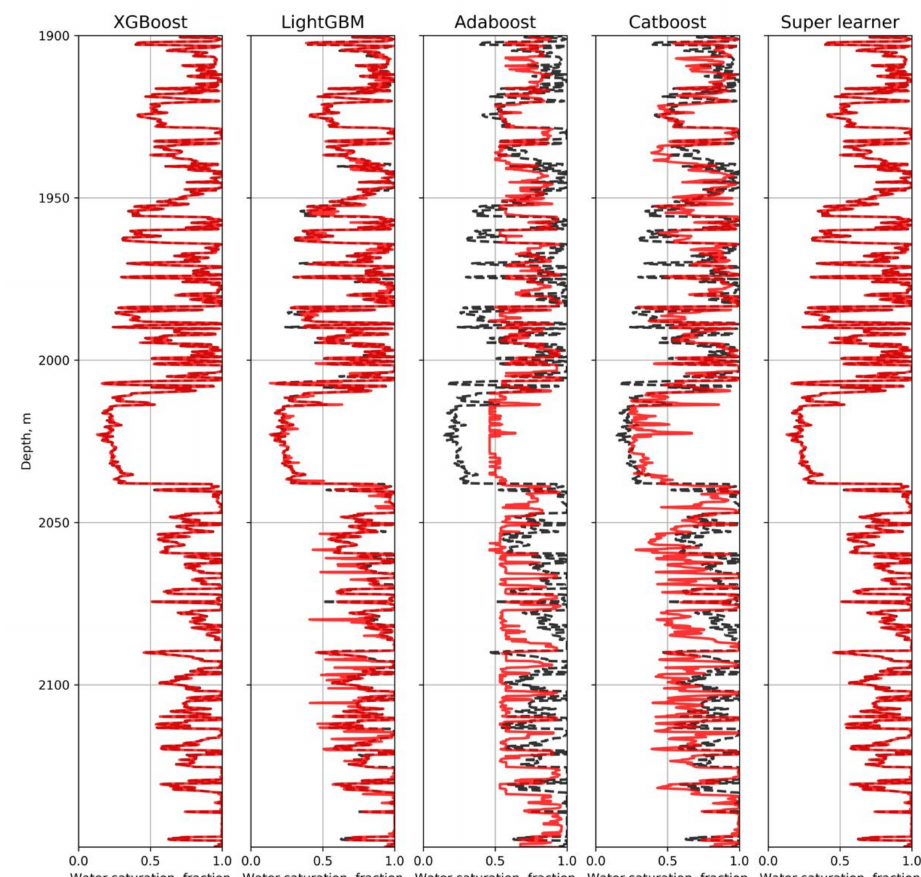
Figure 11. Water saturation prediction results by different algorithms for one well from dataset B where PEF log is kept out, and a perfect match between predictions and Archie-based calculated values are obtained via Super Learner method. In this image, the red line represents predicted values, and the black line is Archie measured ones but verified by experimental